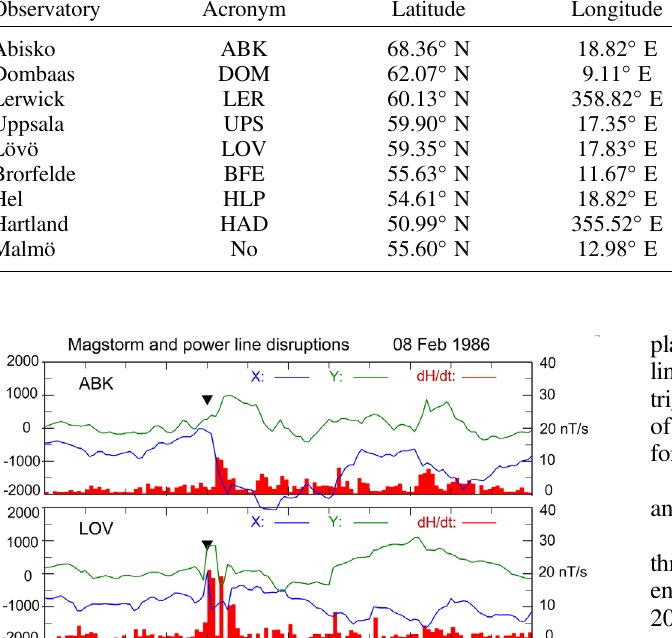
Table 2. Relevant Northern Europe magnetic observatories and Malmö (not observatory). Observatory